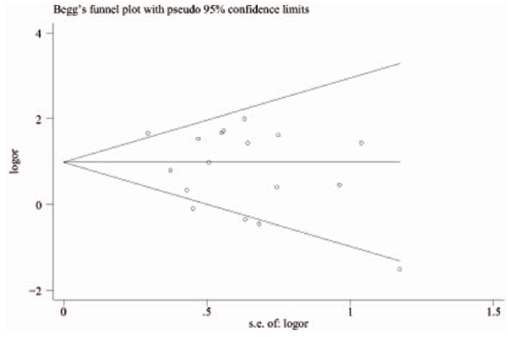
Figure 9. Begg’s funnel plot of publication bias test of severe preeclampsia associated with FVL. LogOR means nature logarithm of OR (odds ratio). Horizontal line means the summary estimate, while the sloping lines mean the expected 95% confidence interval.